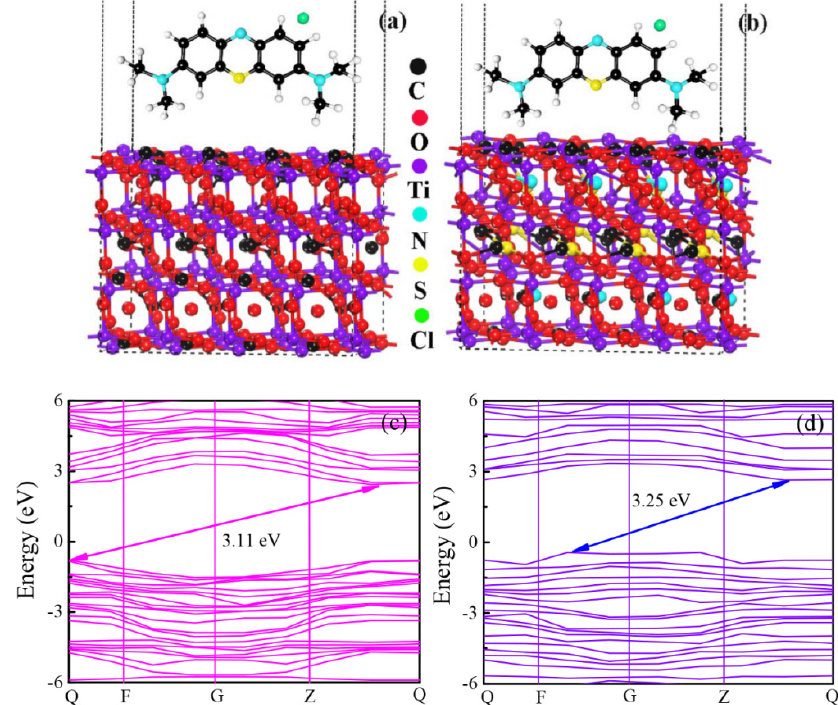
Figure 10. The simulated schematic constructions for the adsorption structures of the calcined ( a ) TiO 2 film and ( b ) keratin char-TiO 2 composite film unit cell with an MB molecule, and for the energy band structures of the calcined ( c ) TiO 2 film and ( d ) keratin char-TiO 2 composite film obtained from DFT calculations.